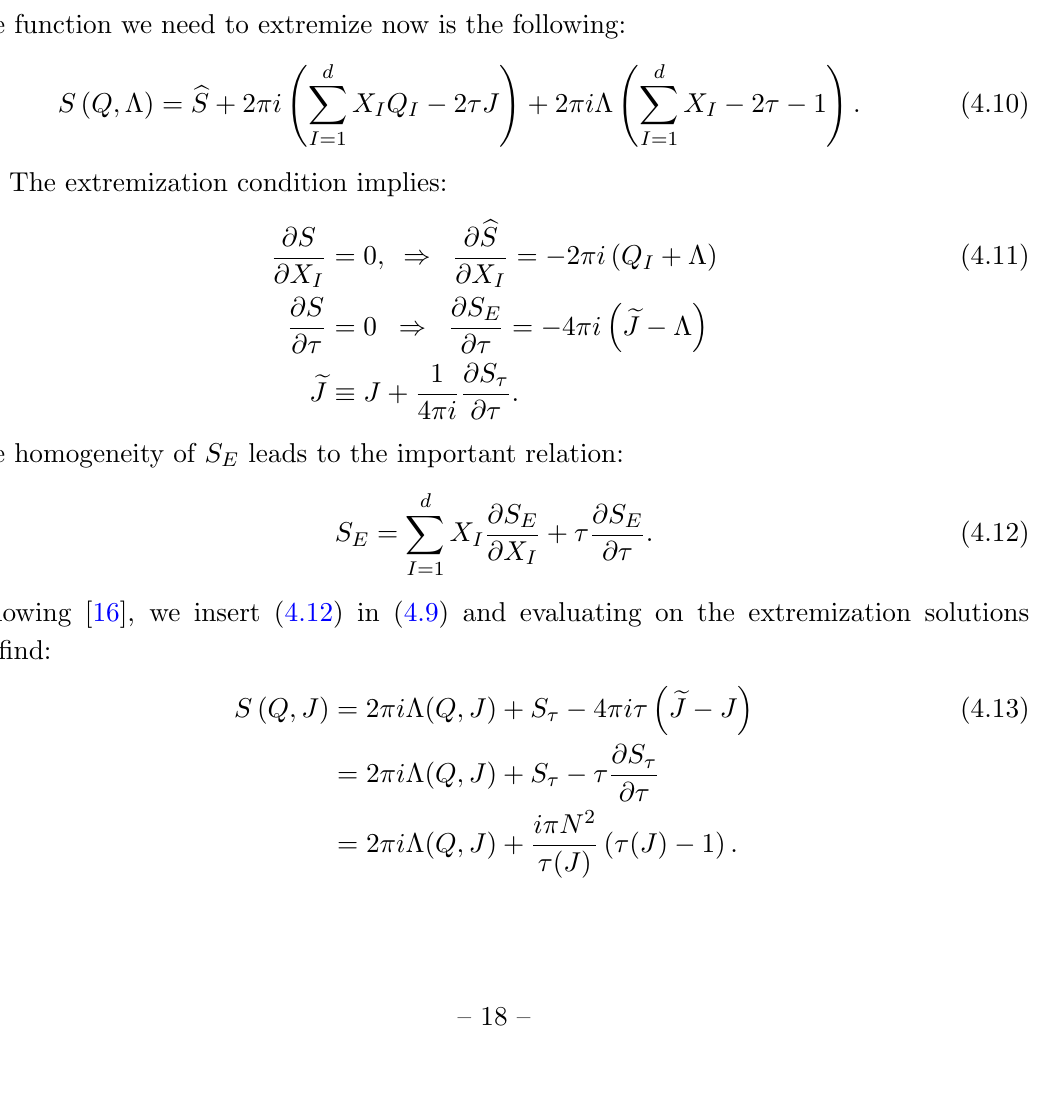
Figure 2 . The (cid:12)gure shows the complex plane of chemical potentials for generic (cid:1) including also the region for the corresponding X I inside the dashed strip. notice that the grey and the dashed region overlap in a zone where the identi(cid:12)cation